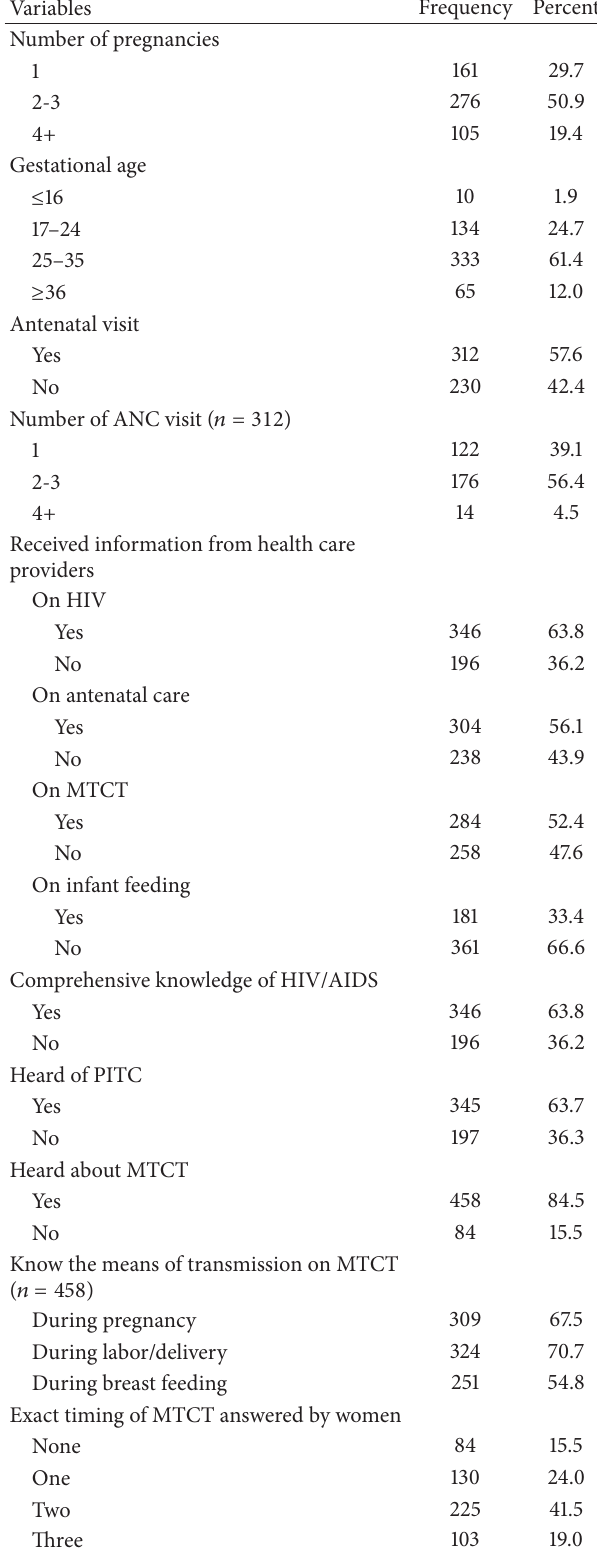
Table 1: Selected sociodemographic characteristics of respondents, Meket district, northeast Ethiopia, 2014 ( 𝑛 = 542 ).